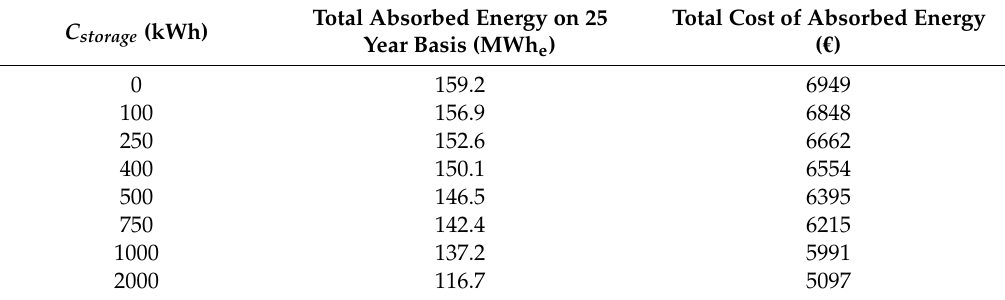
Table 7. Cost of absorbed energy in each scenario of energy storage